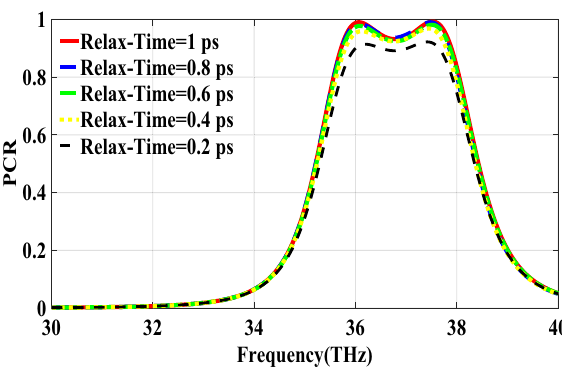
Figure 20. PCR of the third structure for different relaxation times of graphene.